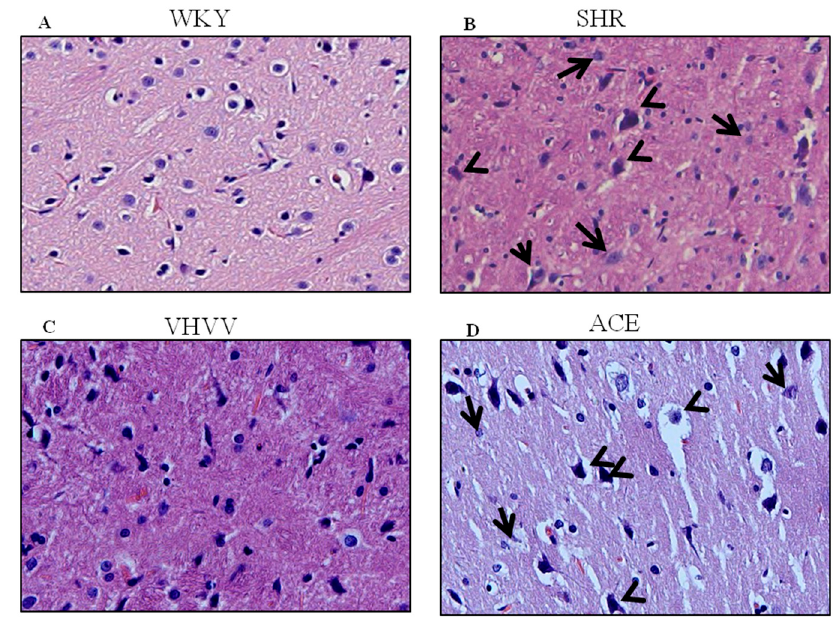
Figure 1. The hematoxylin and eosin (H&E) stain of the cerebral cortex (magnification: 400 × ): ( A ) The control Wistar Kyoto (WKY) group showed a good arrangement of neurons with clear round nucleus; ( B ) the spontaneously hypertensive rats (SHR) group showed neuronophagia, (short arrow), neurodegeneration (large arrow), and abnormal neuronal size (arrowhead; swollen). Of the neurons, ( C ) SHR rats treated with VHVV showed the rearranged neurons with better histopathological arrangement; ( D ) SHR rats treated with Angiotensin-converting enzyme (ACE) showed a moderate level of neurodegeneration (small arrow) and neuronal swollen (arrowhead).